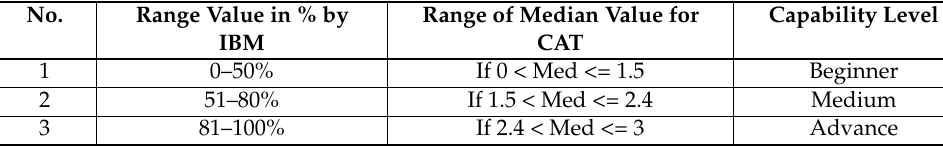
Table 2. Scoring criteria of the CAT framework. No. Range Value in % by Range of Median Value for Capability Level IBM CAT 1 0–50% If 0 < Med <= 1.5 Beginner 2 51–80% If 1.5 < Med <= 2.4 Medium 3 81–100% If 2.4 < Med <= 3